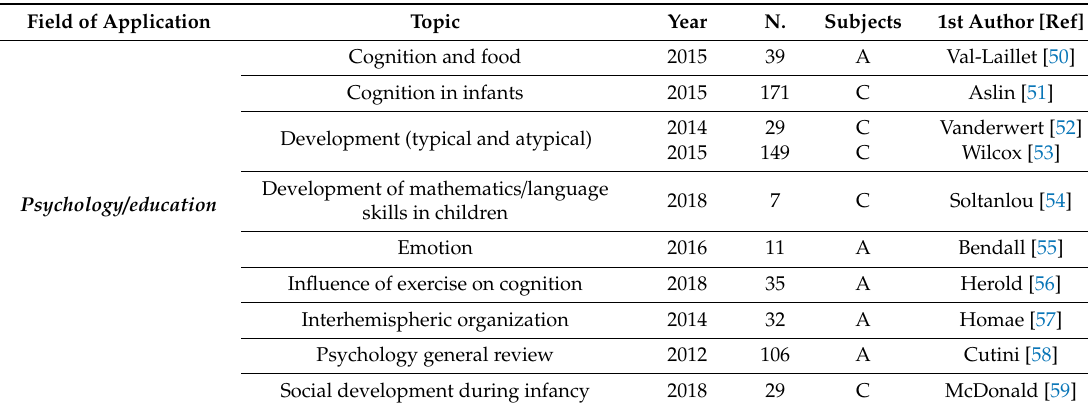
Table 2. Main reviews on the fNIRS applications in the fields of cognitive and social sciences, functional neuroimaging research, and